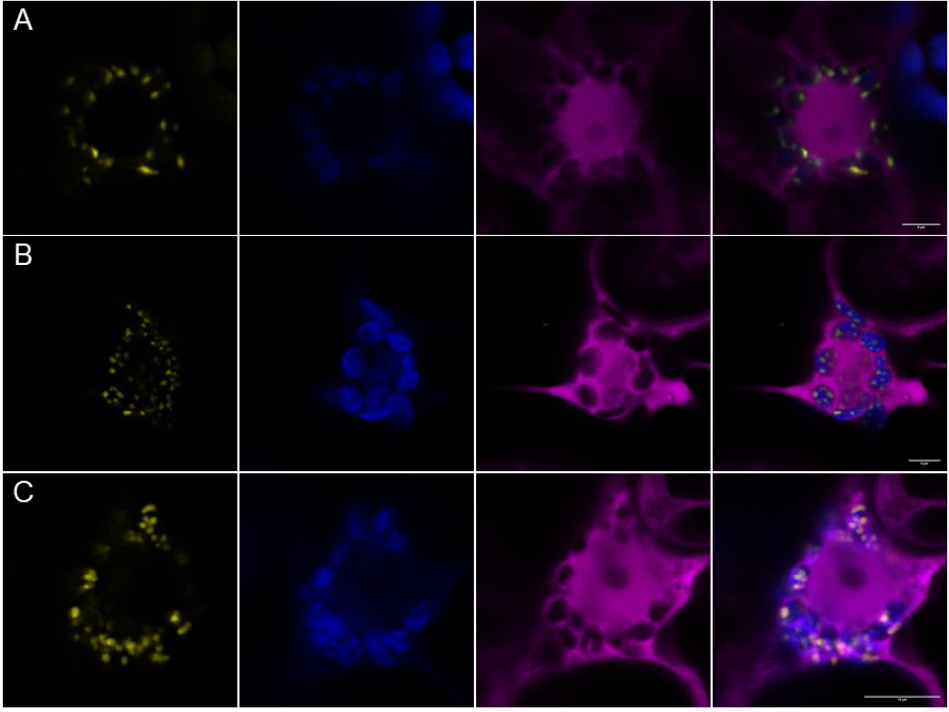
Figure 3. BiFC analysis of At PII with itself and known interactors in PII foci. At PII-nYFP was co-expressed with At PII-cYFP ( A ), At NAGK-cYFP ( B ), and At BCCP1-cYFP ( C ), respectively, under the control of p35S promotor using 2in1-BiFC vectors. Images were taken 3 days after transient transformation of N. benthamiana leaves. In each row, the YFP fluorescence (yellow) is shown first, chlorophyll autofluorescence (blue) is shown second, free RFP fluorescence as expression control (magenta) is shown third, and the merge of all pictures is shown last. Scale bar: 10 µm.